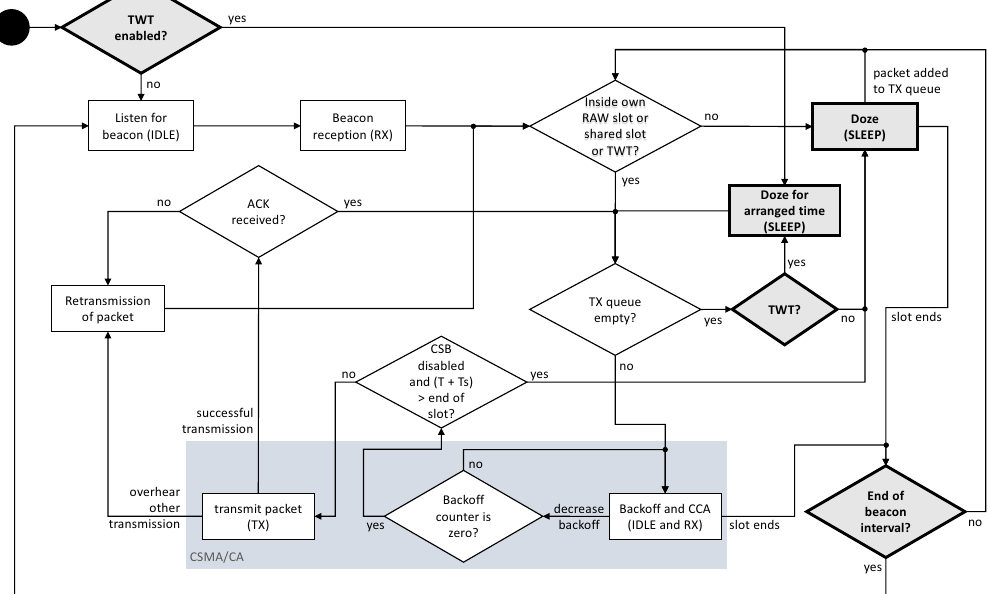
Figure 1. Radio state diagram for the developed energy model of IEEE 802.11ah with restricted access window (RAW) and target wake time